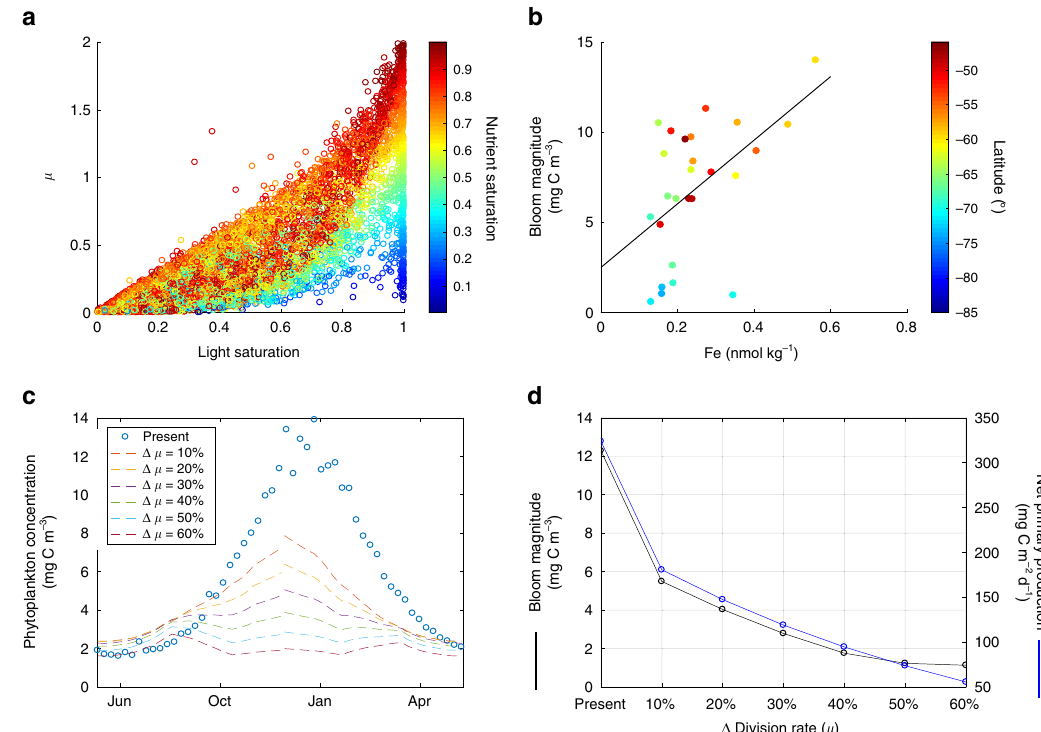
Fig. 4 Light and iron controls on phytoplankton blooms and future projections of biomass and productivity. a Relationship between the mean mixed layer phytoplankton division rate ( μ ) and light and nutrient saturation indices diagnosed by the phytoplankton growth model. b Relationship between bloom magnitude and the surface iron concentration in the Southern Ocean. The continuous black line is obtained from a least-squares linear regression model with a coef fi cient of determination ( R 2 ) of 0.26 and a p -value = 0.006) ( p -value corresponds to an F -test which evaluates whether the linear model fi ts signi fi cantly better than a degenerate model consisting of only a constant term and slope = 0). c Variations in seasonal phytoplankton concentration in the Southern Ocean resulting from a relative decrease (increase) in μ during summer (winter) with respect to the present division rate. d The decrease in mean phytoplankton bloom magnitude (black line and symbols) and annual mean vertically integrated net primary production (NPP, blue line and symbols) in the Southern Ocean as a consequence of relative changes in μ